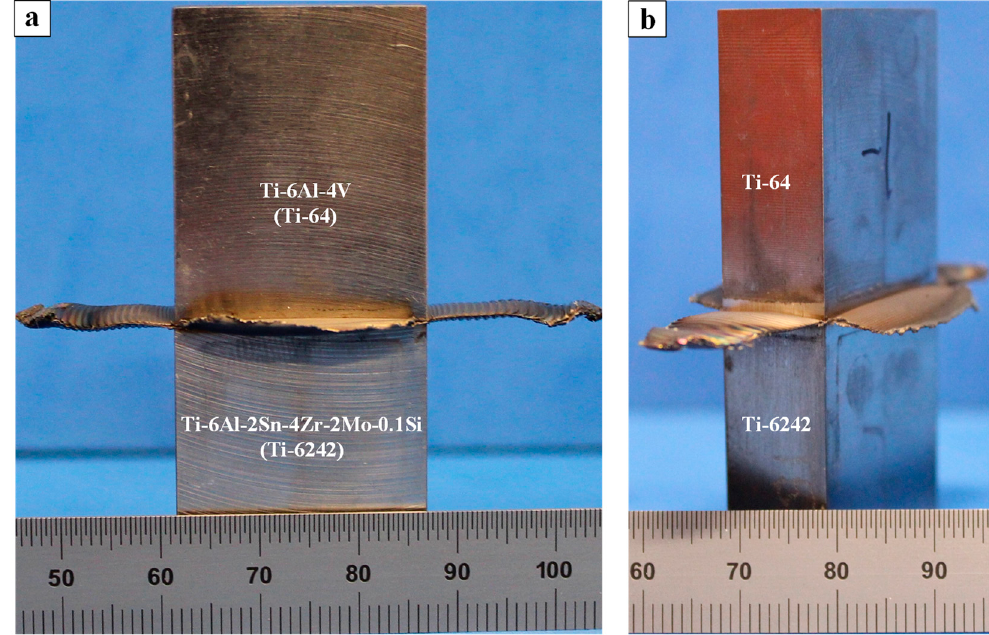
Figure 3. Linear friction welded specimen with flash extruded along the edges ( a ) front view ( b ) side view.